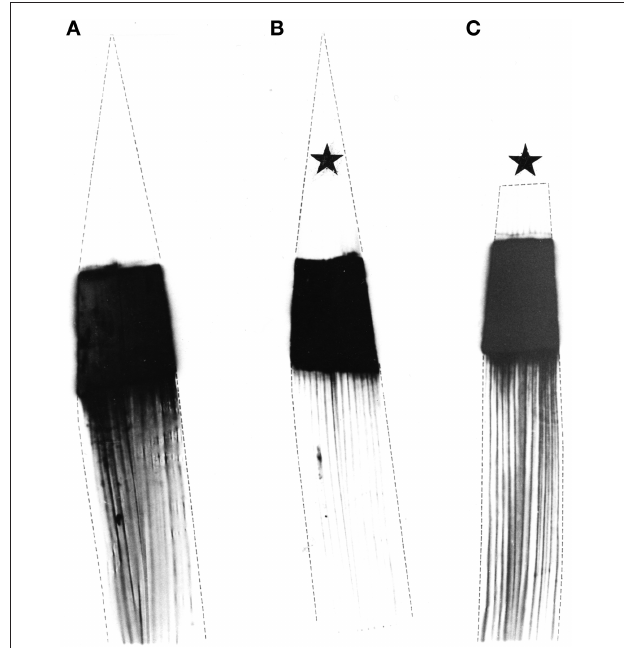
FIGURE 3 | Macroautoradiographs of three maize leaves which were labeled with 14 CO 2 for 30min in the middle section. Labeled assimilates were exported in a basipetal direction. (A) The left leaf remained unstimulated, (B) the middle leaf was cold-shocked at the tip (starlet) and (C) the right leaf was wounded at its tip (starlet) once per min.